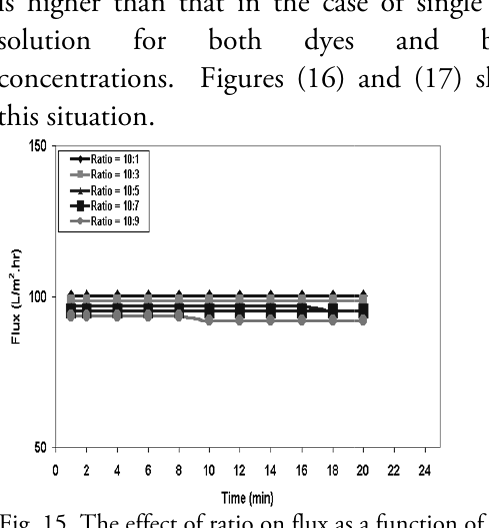
Fig. 15. T for t the case of con